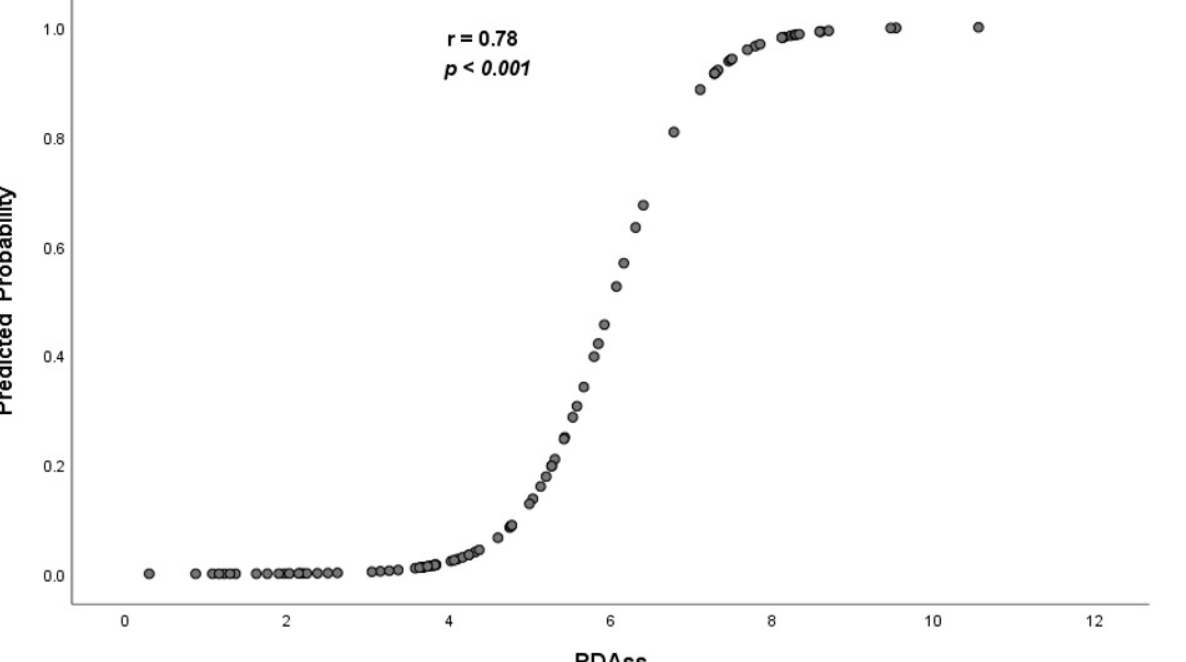
Figure 4. Receiver operating characteristics curve of the ability of PDAss to predict CLD/death.